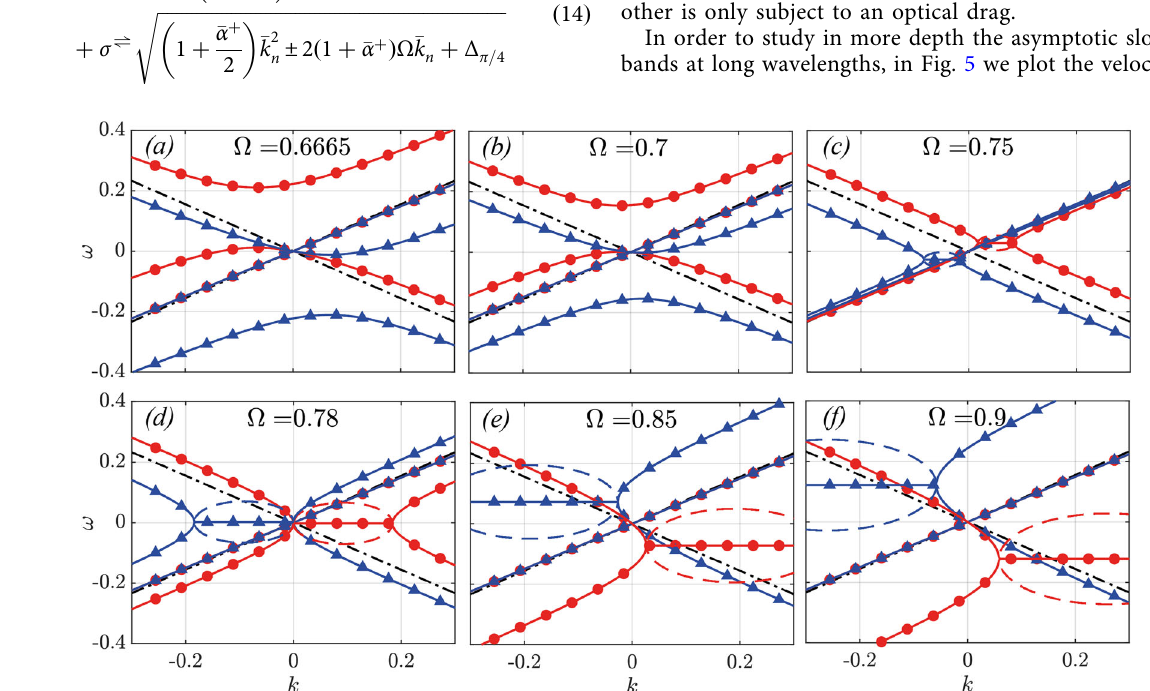
Fig. 4 Band structures across the luminal regime for the ϕ = π /4 case. As in the previous scenario α = 0.4 and the colour/marker scheme is identical. The different panels correspond to modulation frequencies (and velocities) ( a ) Ω = 0.6665, ( b ) Ω = 0.7, ( c ) Ω = 0.75, ( d ) Ω ¼ 0 : 78 (cid:4) Ω 0 and ( f ) Ω = 0.9. Note the qualitative difference with the ϕ = 0 case in the character of the complex bands. Note how the band gaps here are either purely vertical or purely horizontal. Moreover, k -gaps in this system appear below the luminal limit, in contrast to all previous observations, where they only appear in superluminal